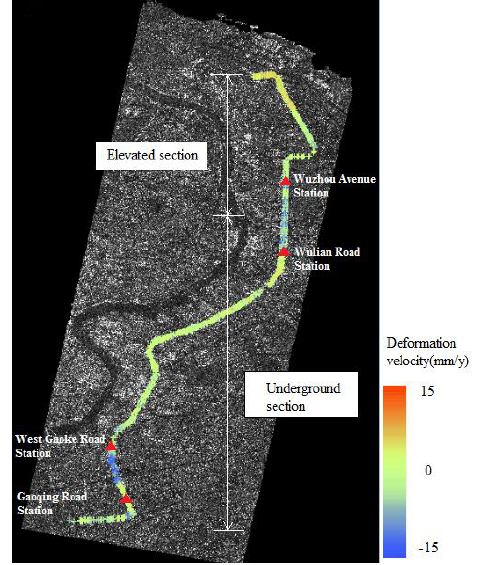
Figure 5. The deformation rate along Shanghai Metro Line 6 by 32 scenes of Cosmo-SkyMed descending images